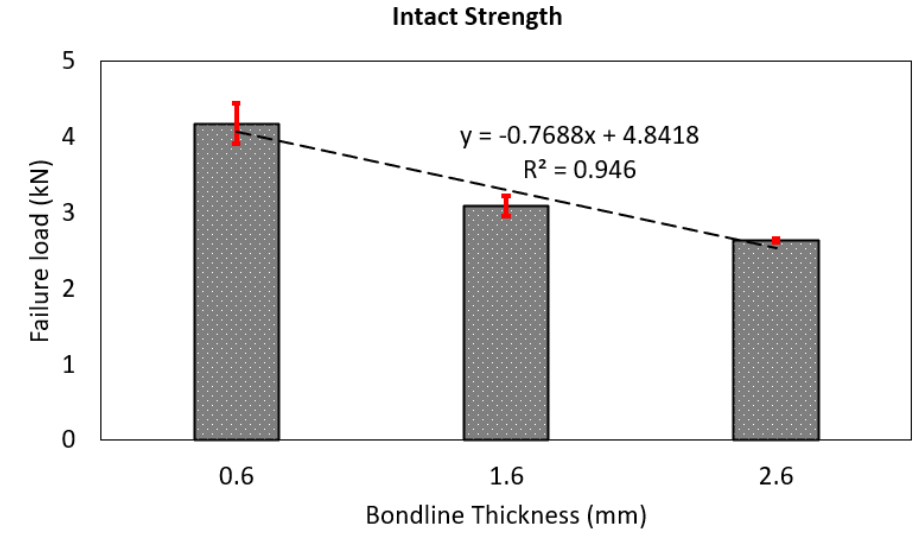
Figure 14. Comparison of intact failure loads with varying bondline thicknesses.